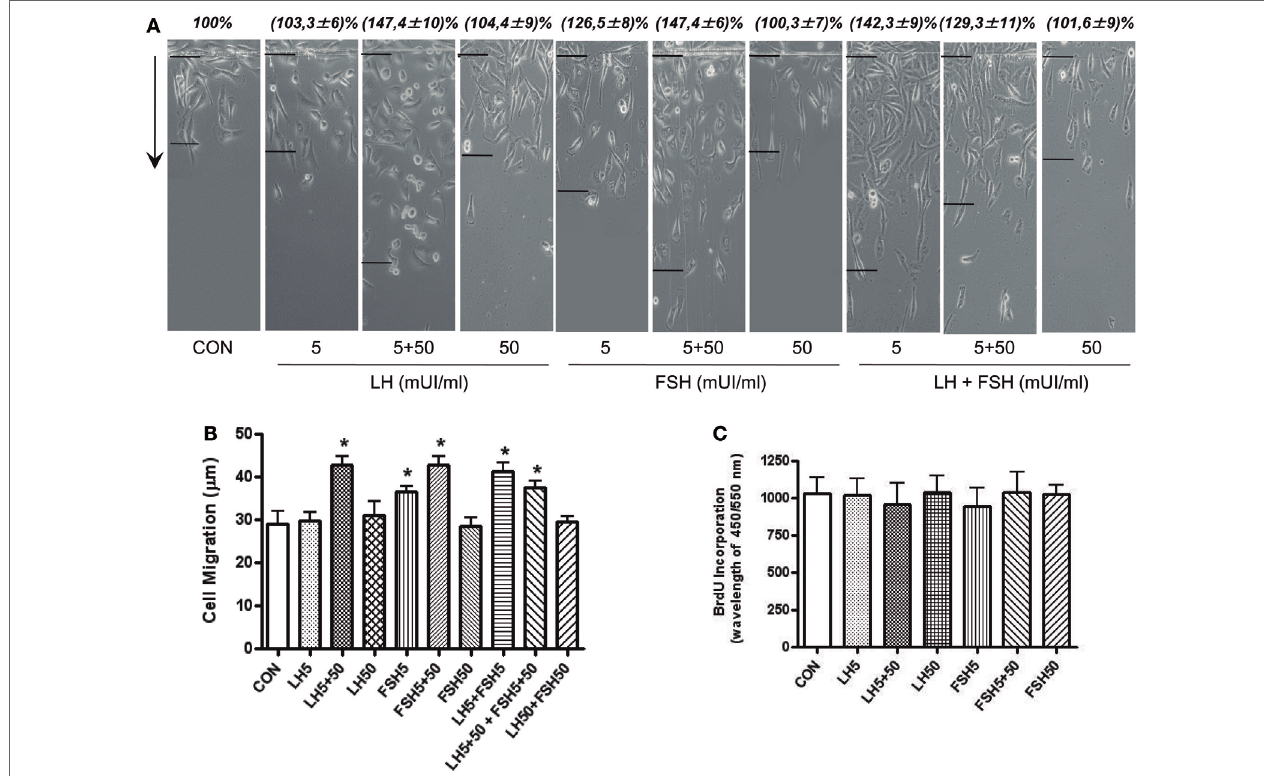
FigUre 2 | LH/follicle-stimulating hormone (FSH) promote breast cancer (BC) cellular migration. (a) T-47D BC cells were treated with LH and FSH in different concentrations (5, 5 + 50, and 50 mUI/ml) for 48 h. Horizontal cell migration was measured as the number of cells crossing the starting line or as the mean migration distance from the starting line. Sample images of horizontal migration in the different conditions are shown; the black lines indicate the mean migration distances. (B) Mean cell numbers or mean migration length is shown. Results are expressed as the mean ± SD of three separate experiments. * P ≤ 0.05 vs. control. (c) Effect of a 48-h exposure to LH and FSH on DNA synthesis of T-47D cells, as quantified by the bromodeoxyuridine assay. Data shown are representative of three independent